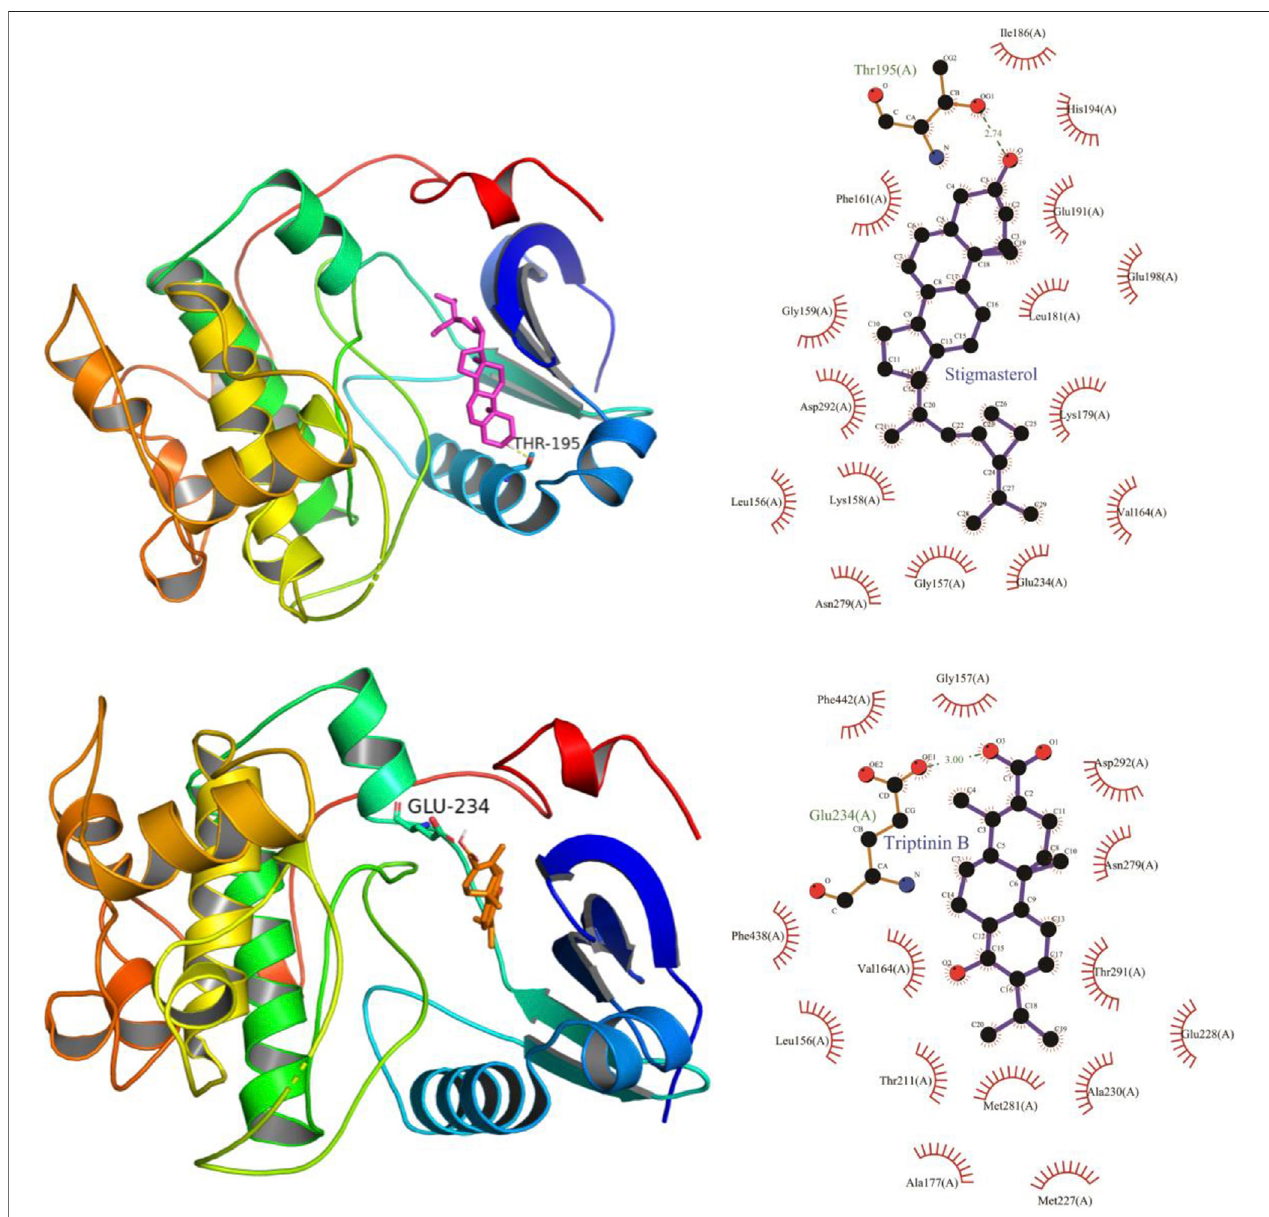
FIGURE 7 | Molecular docking diagram of TW core compounds and